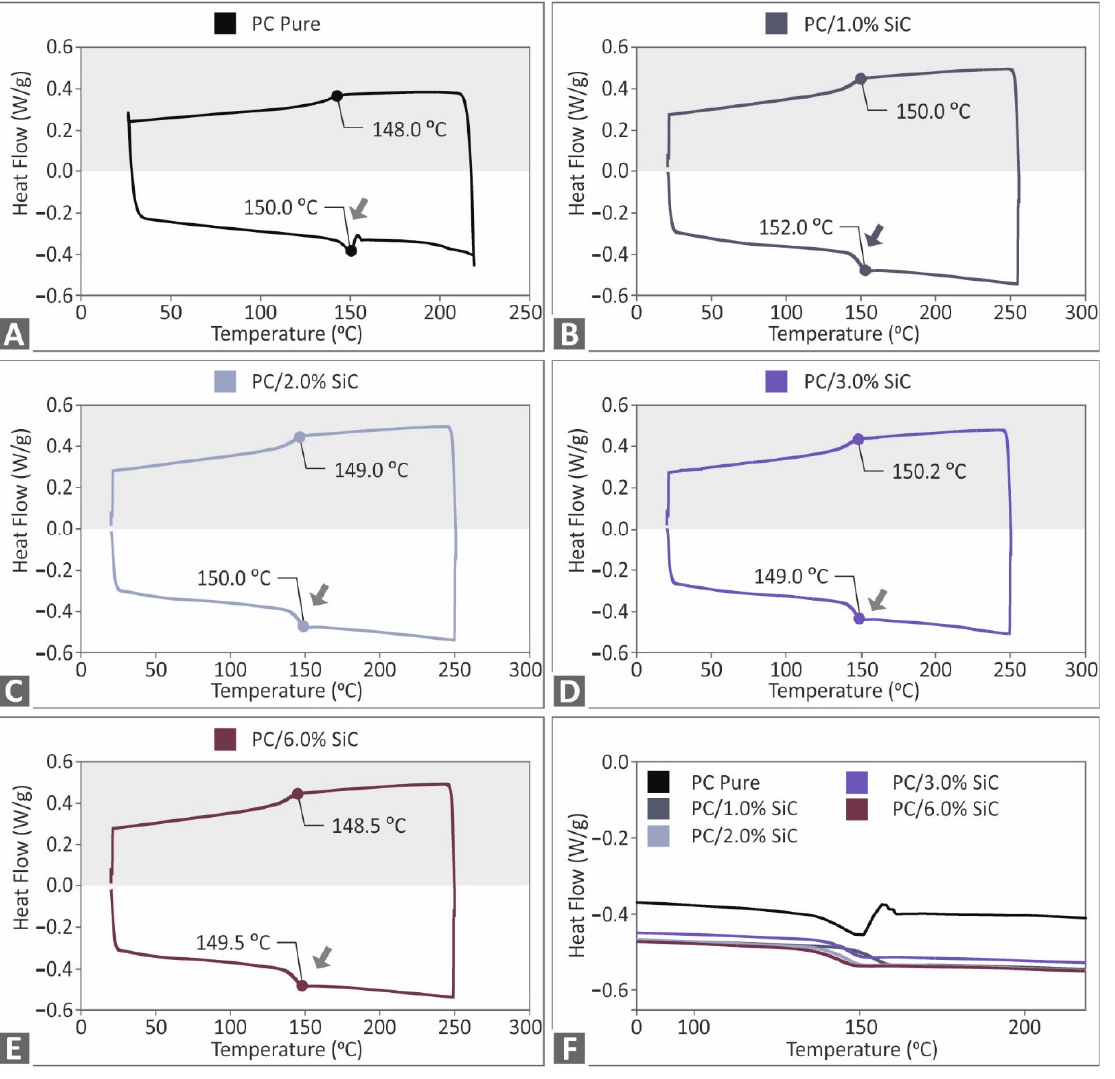
Figure 3. Pure PC and PC/SiC nanocomposites DSC results (endotherm and exotherm heat flow graph, W/g, compared to temperature, ◦ C) for PC: ( A ) pure, ( B ) SiC 1 wt.%, ( C ) SiC 2 wt.%, ( D ) SiC 3 wt.%, ( E ) SiC 6 wt.%, and ( F ) zoom on the exotherm graphs for comparison purposes.